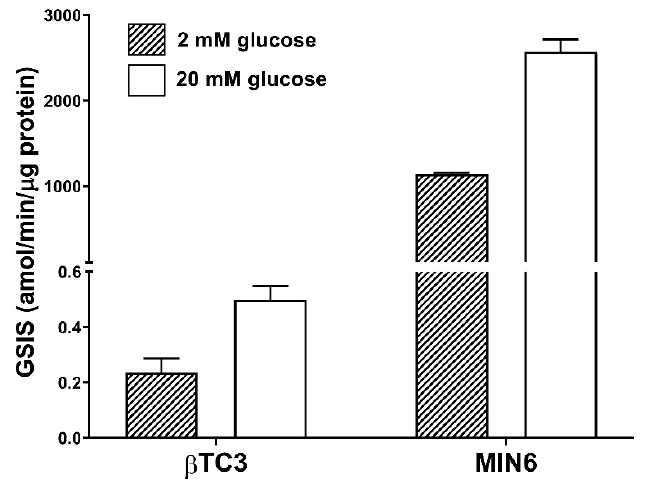
Figure 1. The efficiency of glucose-stimulated insulin secretion (GSIS) in β TC3 and MIN6 adherent